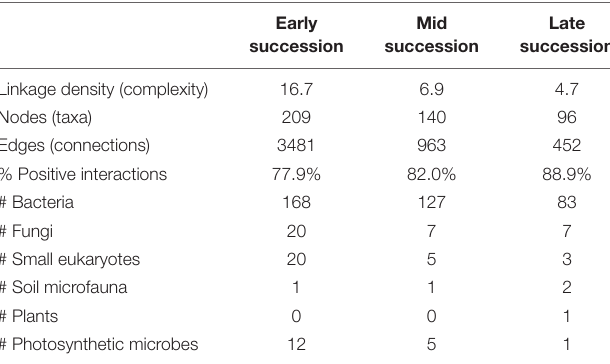
TABLE 2 | Network statistics for microbial networks across a successional gradient (for the network diagrams, see Figure 3 ). Early Mid Late succession succession